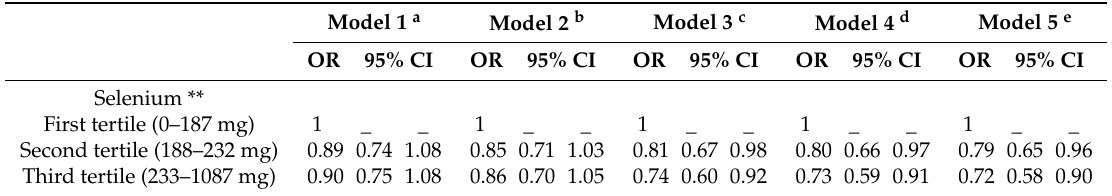
Table 3. Logistic regression models between subclinical hypothyroidism (outcome)* and selenium intake adjusted for the consumption of zinc, vitamin A, total and saturated fats and urinary sodium. ELSA-Brasil study,